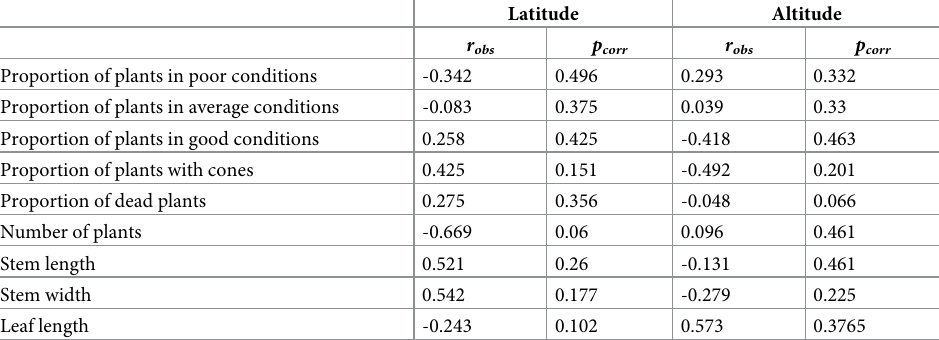
Table 1. Linkage between population features and the stand latitude and altitude. Results of the null-model corre- lation analyses (Pearson r and corrected p values for multiple